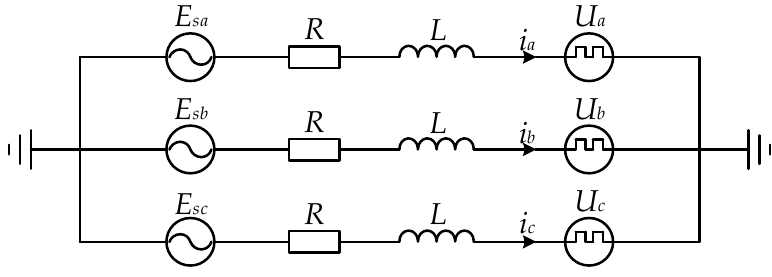
Figure 3. Structure diagram of the AC side equivalent circuit.